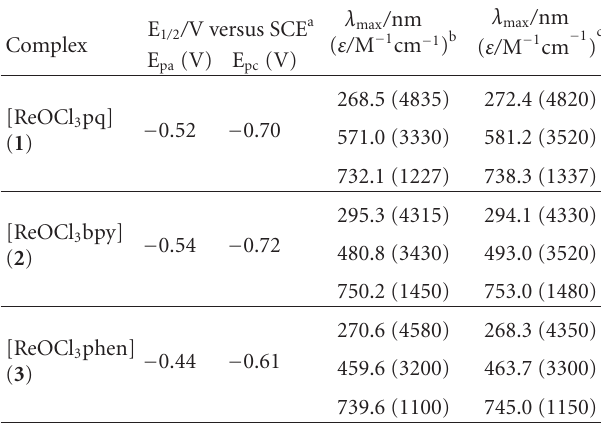
Table 1: Electrochemical and absorption data of the oxorhenium (V)